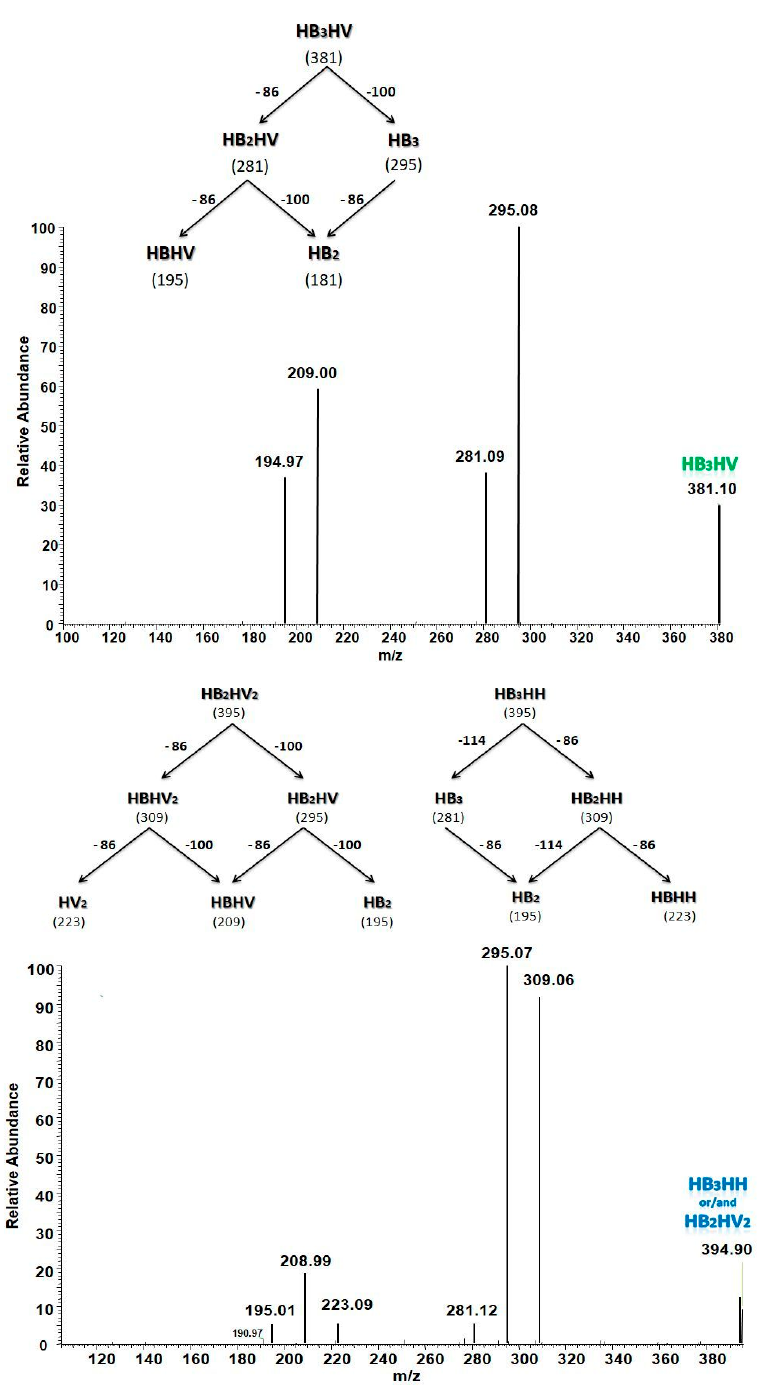
Figure 11. The ESI-MS / MS fragmentation spectra of the selected parent sodium adducts of [HB 4 + Na] + at m / z 367, [HB 3 HV + Na] + at m / z 381, and [HB 2 HV 2 + Na] + or / and [HB 3 HH + Na] + at m / z 395 oligomers selected from the ESI-mass spectrum in Figure 10.